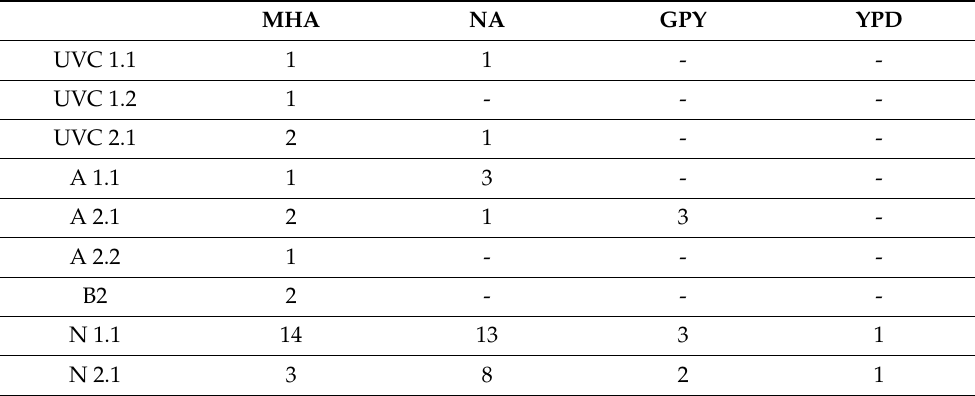
Table 3. Culture media that showed bacterial growth—number of culture-forming unites (CFU) in each Petri